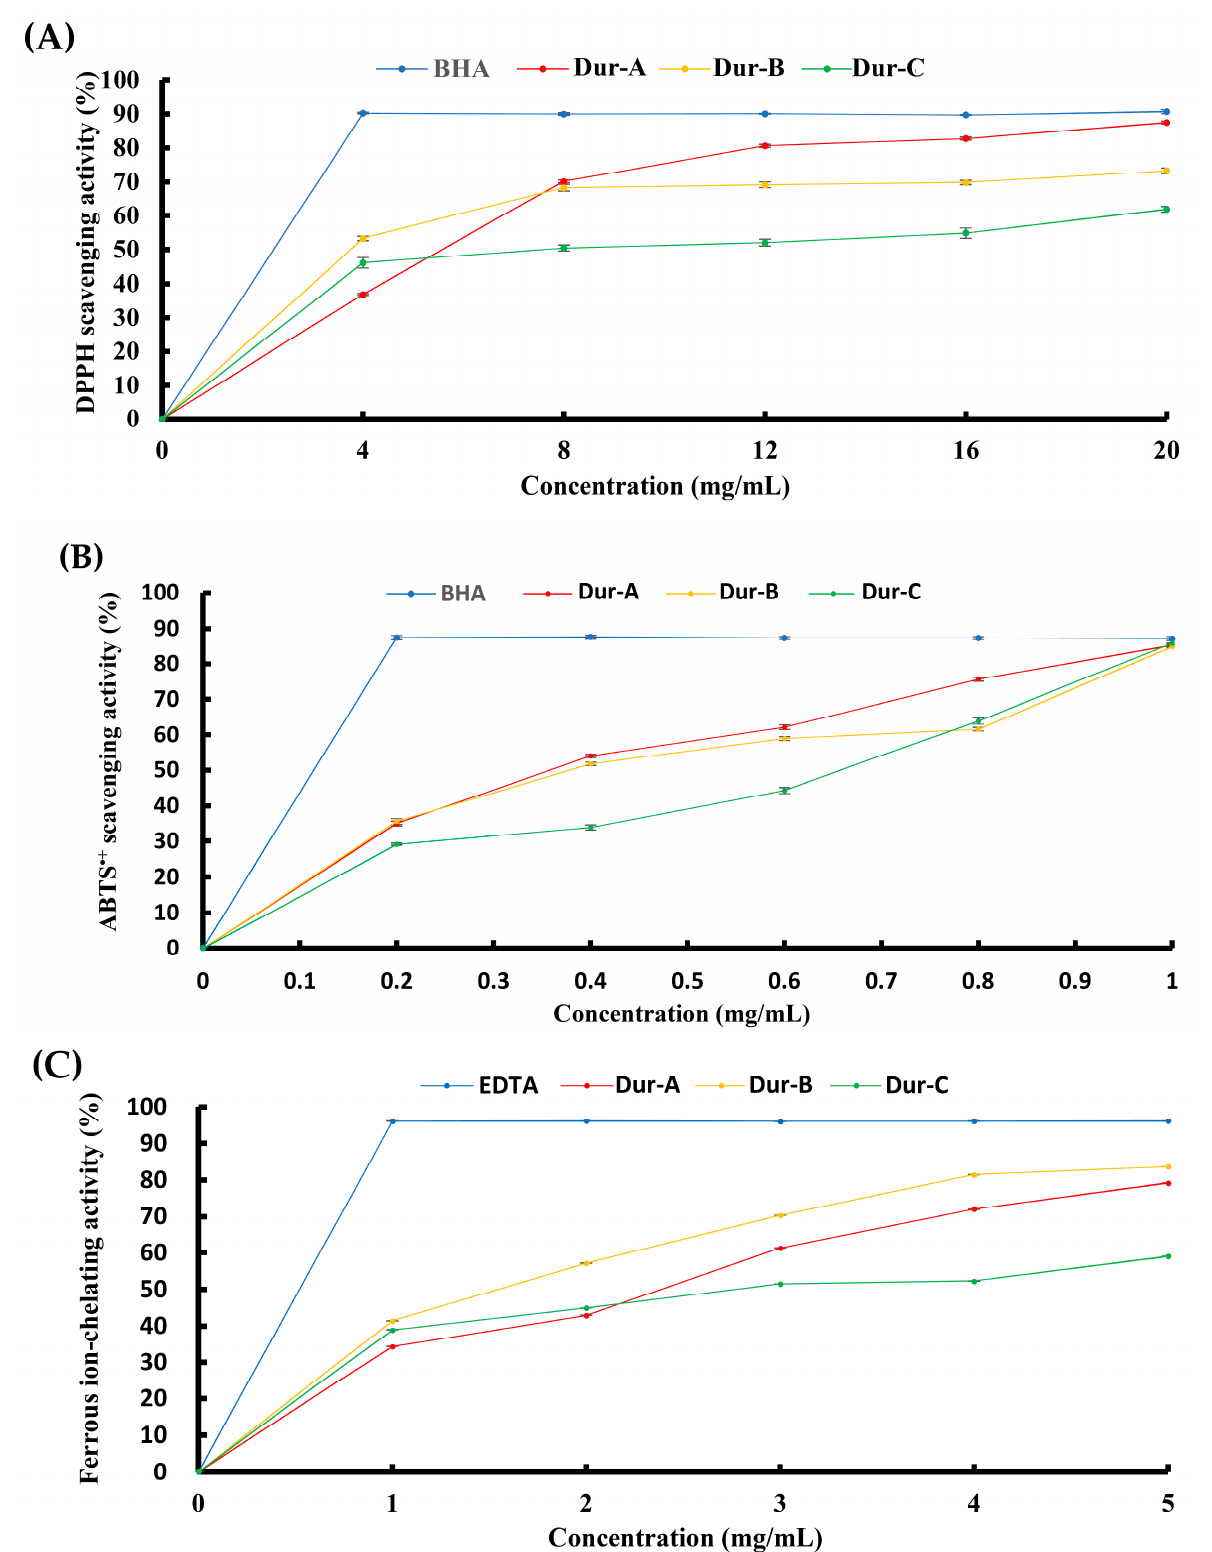
Figure 2. Antioxidant activities of Dur-A, Dur-B, and Dur-C. ( A ) DPPH radical-scavenging activity for Dur-A, Dur-B, Dur-C, and BHA. ( B ) ABTS radical-scavenging activity for Dur-A, Dur-B, Dur-C, and BHA. ( C ) Ferrous ion-chelating activity for Dur-A, Dur-B, Dur-C, and